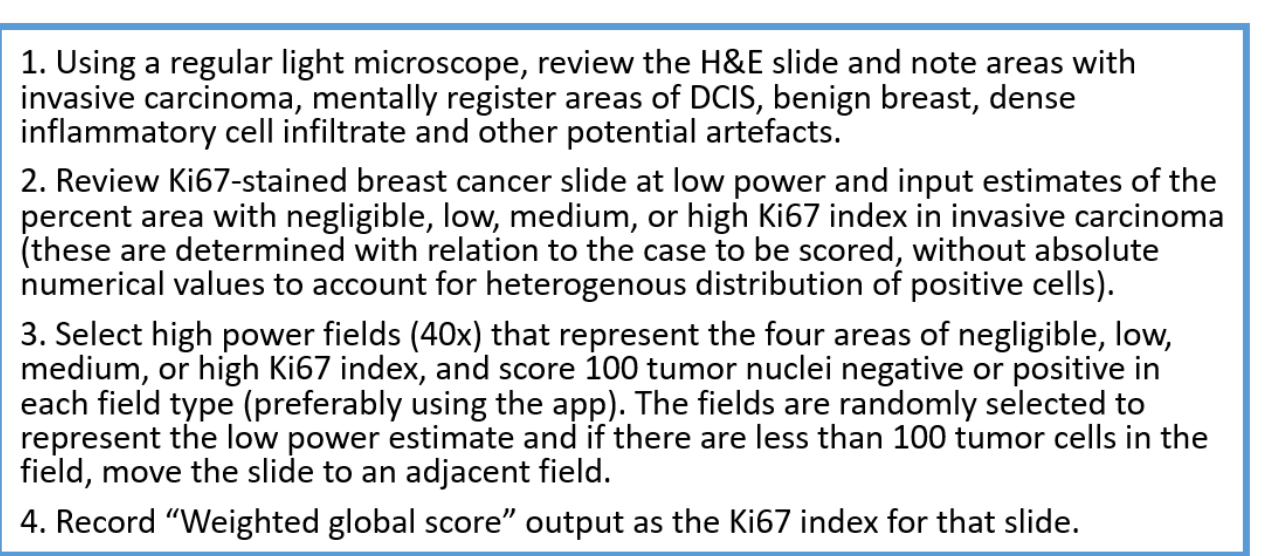
Figure 3. How to select 4 high power fields for global Ki67 assessment across the tumor.